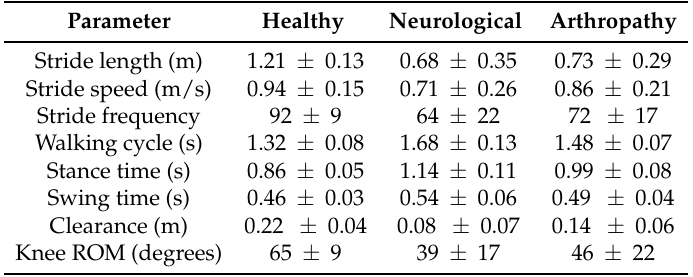
Table 4. Gait parameters comparison for healthy subjects and patients. Results are presented as mean ( ± SD).